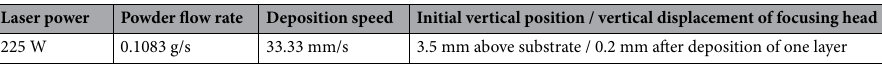
Table 2. LMD process parameters used to build the 316LSS wall in Fig.